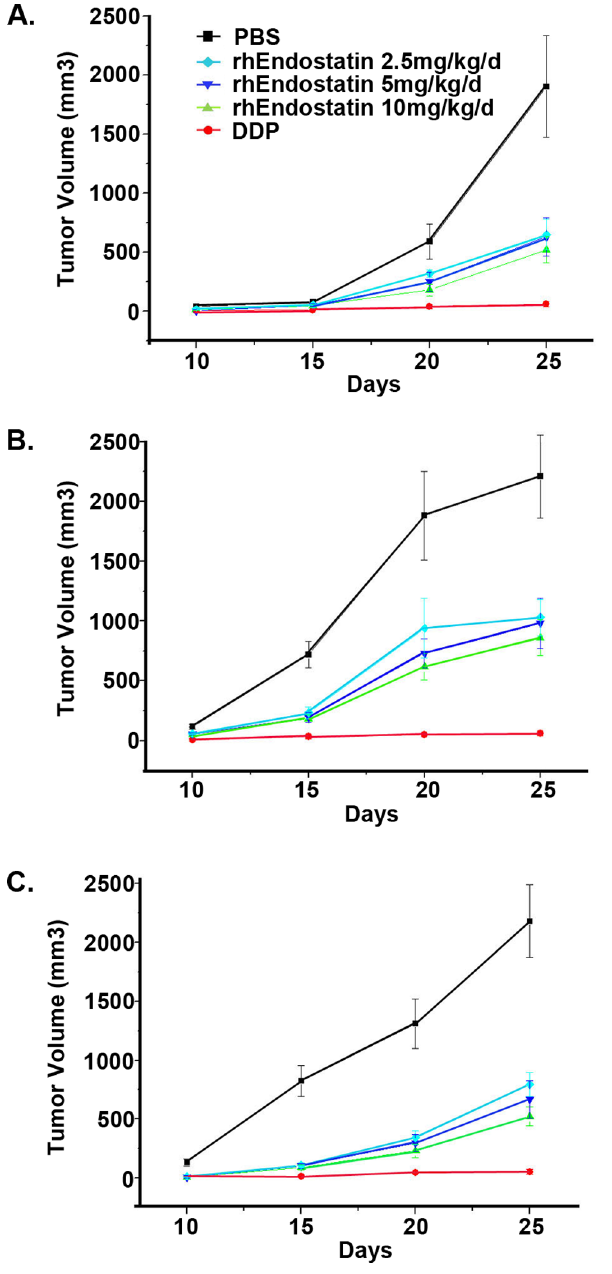
Figure 4. Inhibition of human tumor growth by administrating rhEndostatin intravenously. Hepatocellular carcinoma QGY-7703(A), A549 lung carcinoma(B), or Bcap37 breast cancer cells(C), were implanted to nude mice at the dosage of 6 6 10 6 cells each, subcutaneously. Tumor-bearing mice were treated with either DDP N ), or rhEndostatin 10 mg/kg/ (2 mg/kg/day) for successively 7 days( day( m ), rhEndostatin 5 mg/kg/day( . ), and rhEndostatin 2.5 mg/kg/ day( % ) for successively 15 days. PBS( & ) was injected as the vehicle control. Results were presented as mean 6 SD (n=10, each). Mice administered with rhEndostatin i.v. exhibited a significant reduction in tumor volume, compared with that in vehicle control group.